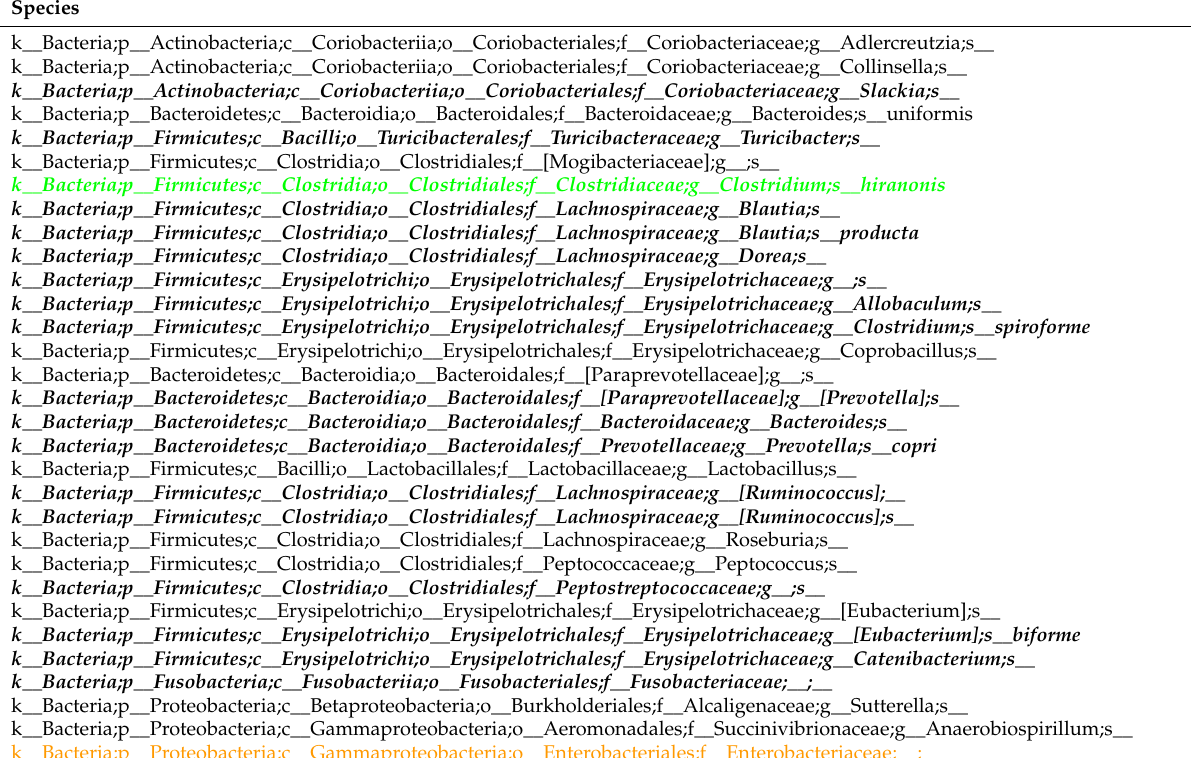
Table 2. List of the key species differentiating between healthy and CE microbiomes. The species were selected by intersecting the relevant species list coming from differential abundance (DA), RF, and sPLS-DA analyses. Only the species that were present in at least two out of three of these lists were included in this table, where the last column shows the number of methods that identified them as relevant (see Materials and Methods). Species in bold italic are taxa belonging to the core species list (see Results), while the green and orange colored ones are taxa included in or related to the Dysbiosis Index. Taxonomies ending with “s__” mean that there was the best match in Greengenes, but that best match did not have an assignment at the species level. In contrast, a “__” is used to indicate that classification did not arrive down to the species level because a close match did not exist in the reference database or because multiple equivalent matches were available.